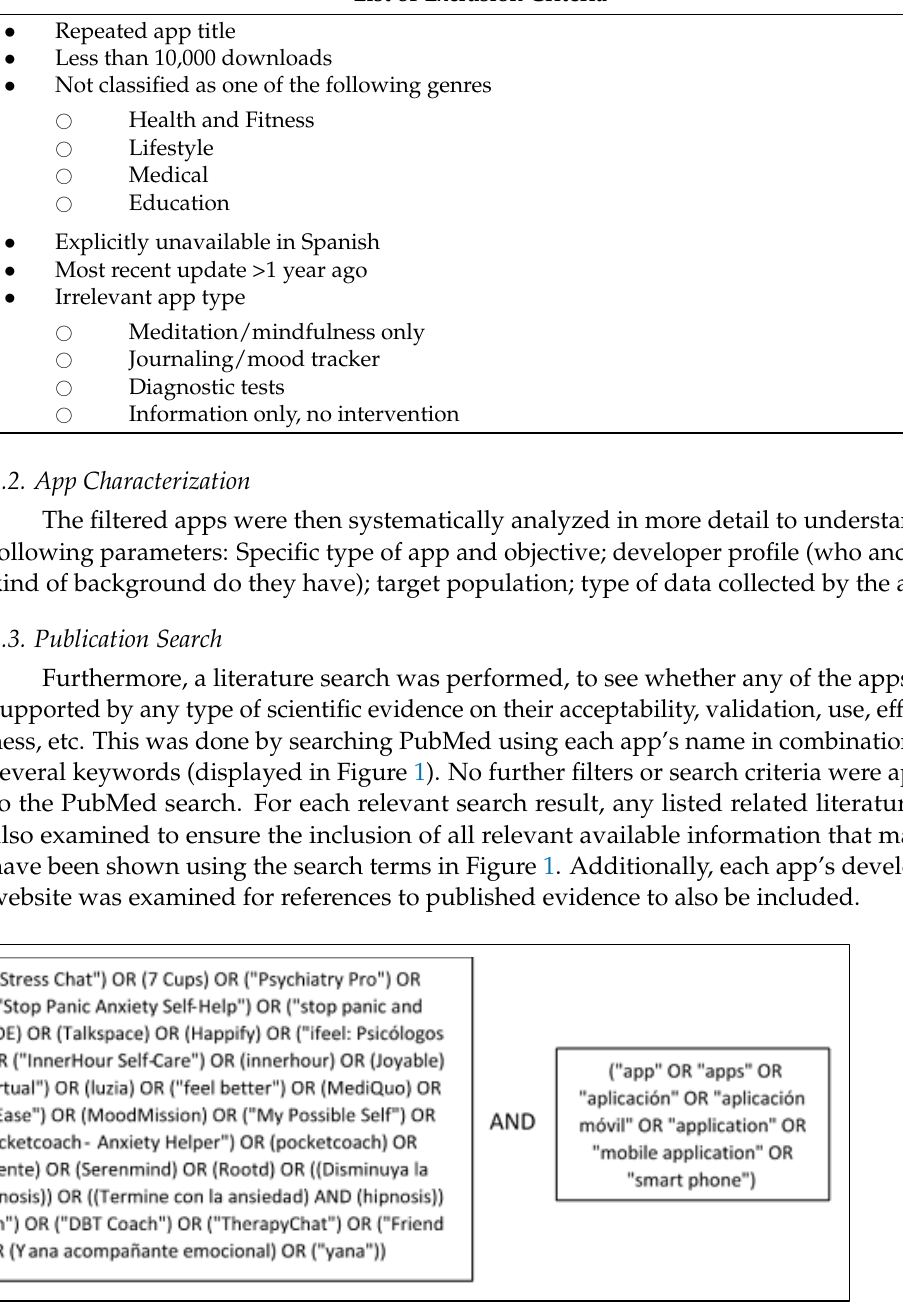
List of Exclusion Criteria